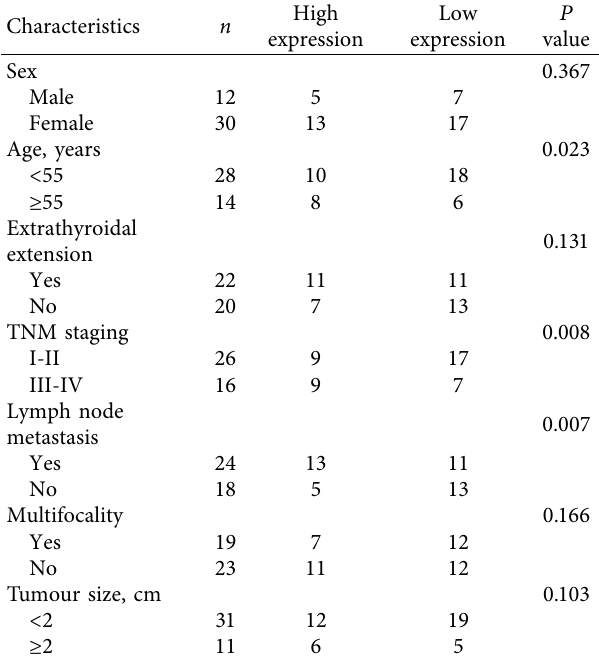
Table 1: Correlation between clinicopathological features and miR-576-5p expression in 42 patients with